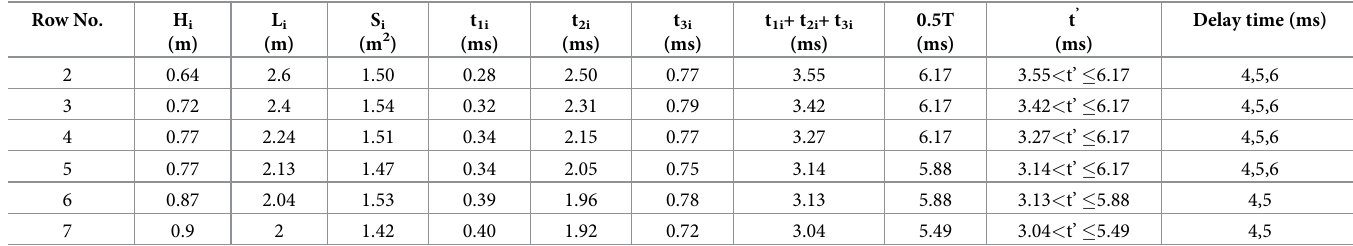
Table 6. Millisecond delay times of different blast holes. Row